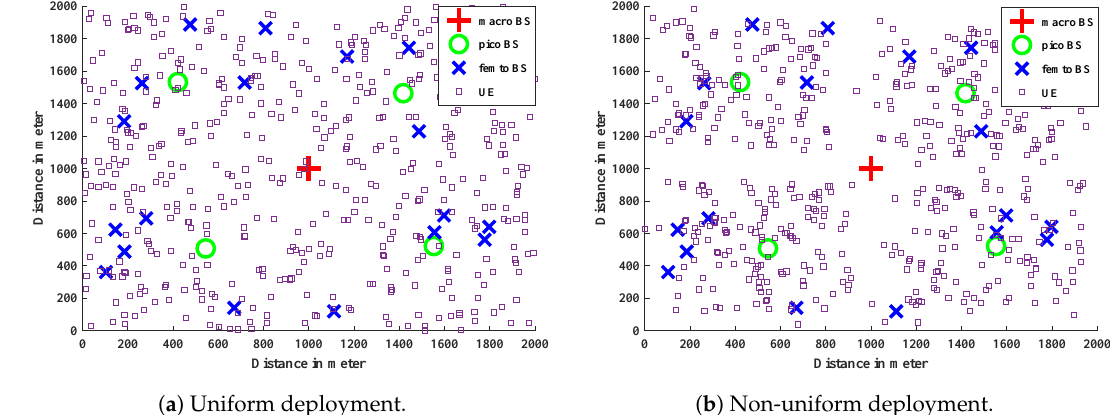
Figure 5. UE and BS deployment in the network.